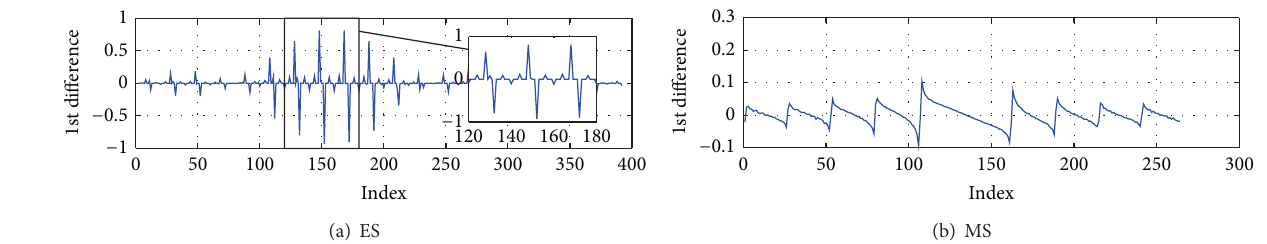
Figure 6: First-order difference sequence.